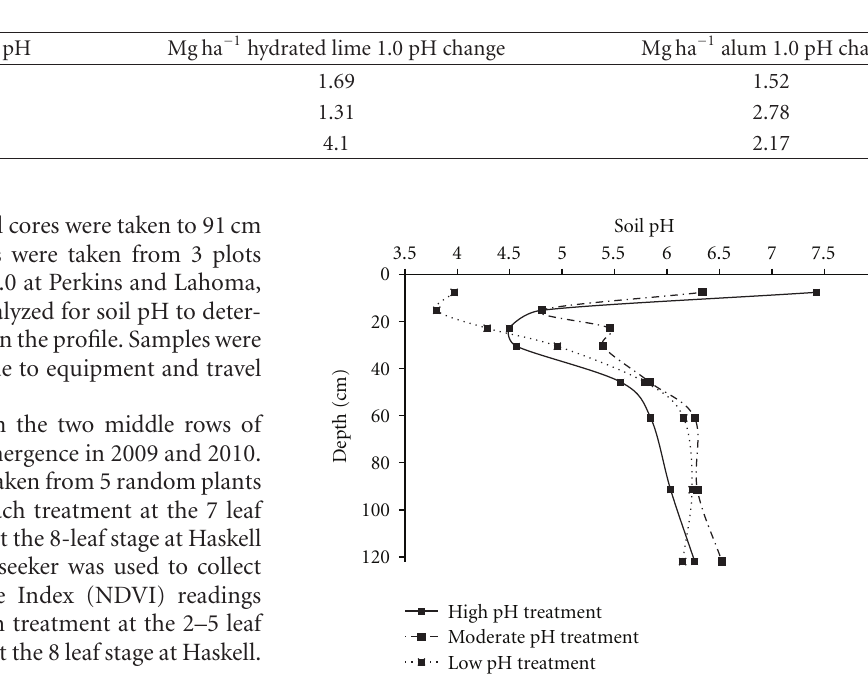
Figure 1: Postharvest soil profile pH at Perkins, Oklahoma for target pH treatments of 4.0, 6.0, and 7.0 (2010).